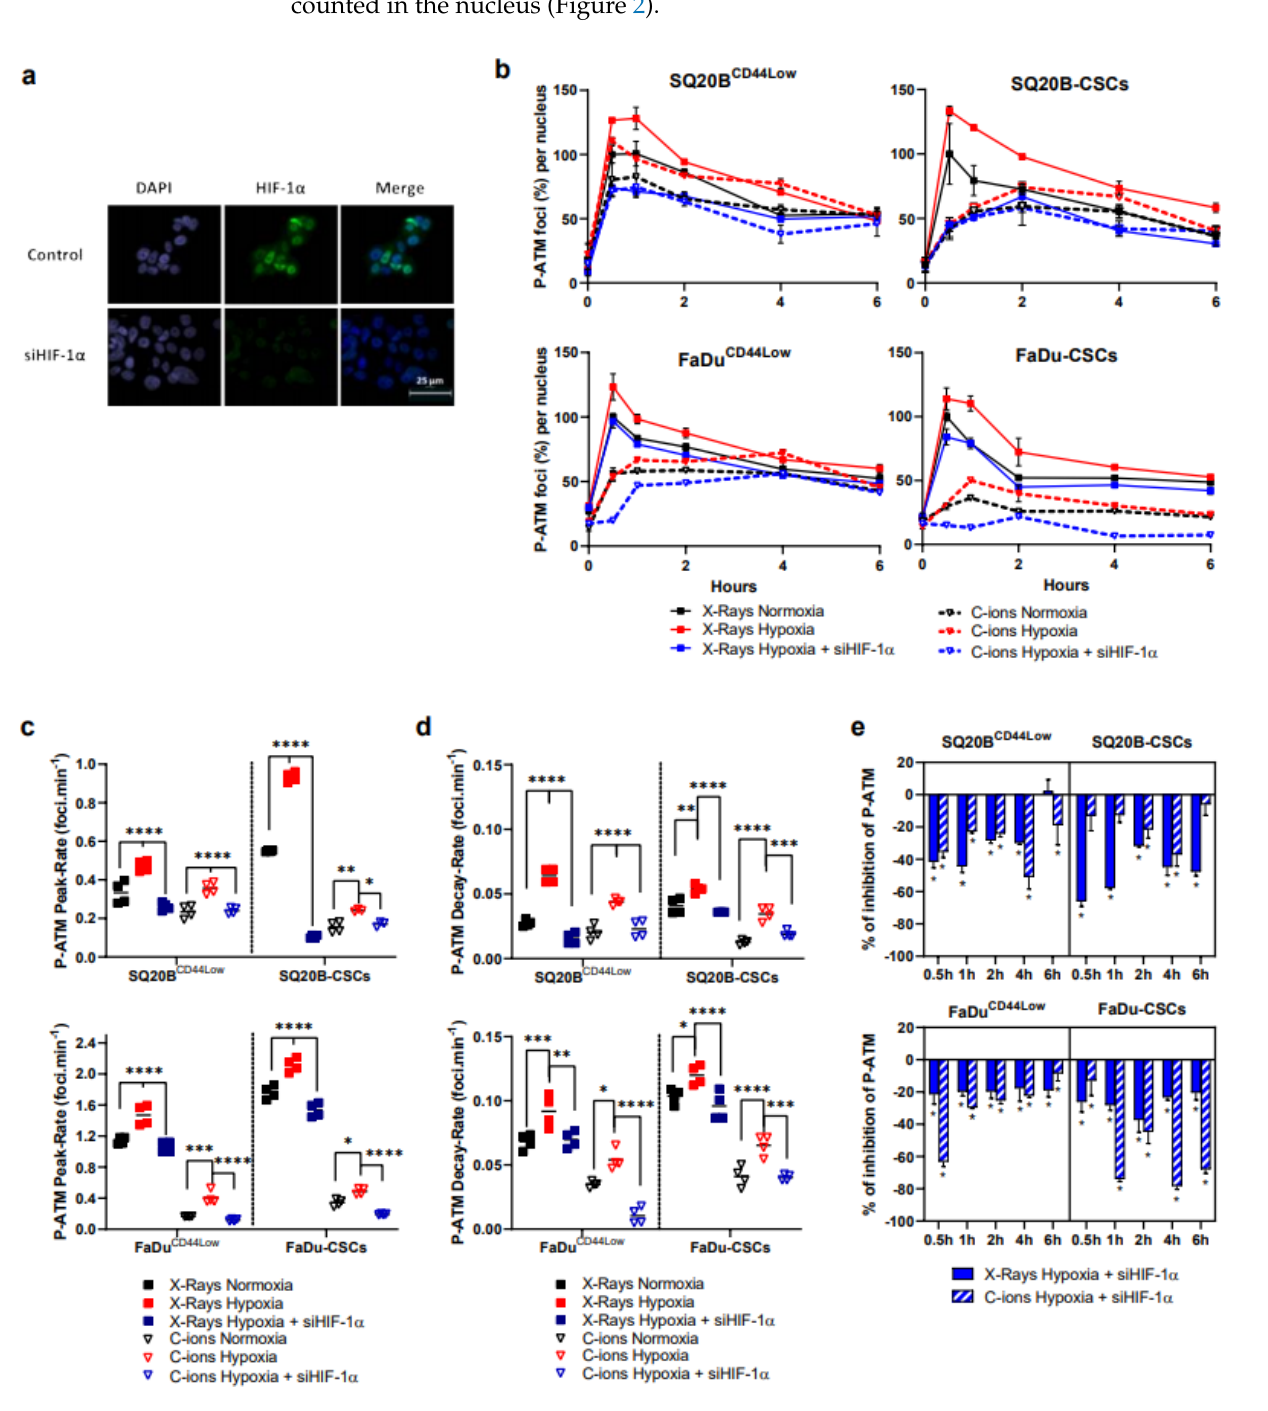
Figure 2. The silencing of HIF-1 α combined with photons and C-ions decreases the initiation of the signaling of DSBs under hypoxia. ( a ) Representative images of silencing of HIF-1 α in SQ20B CD44Low cells under hypoxia at 4 h. ( b ) Kinetics of ATM phosphorylation (P-ATM) after 2 Gy X-Rays or C-ions, ± siHIF-1 α . The percentages of foci per nucleus were calcu- lated for each condition considering the X-Ray normoxic peak as the reference. The symbols and error bars indicate means